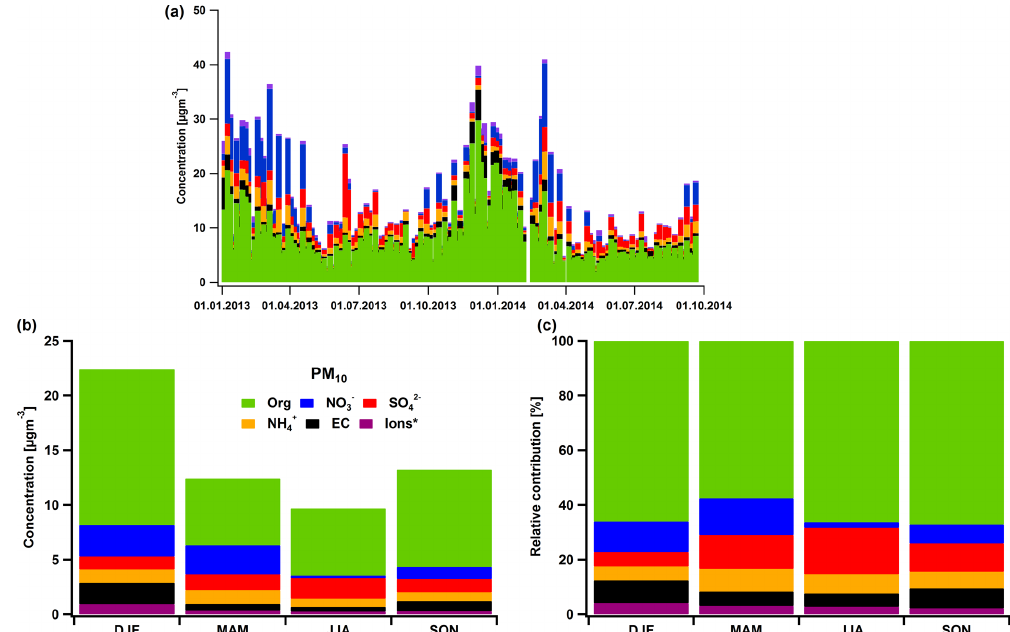
Figure 1. Concentrations of OM, EC and major ionic species for the years 2013 and 2014 (a) , their seasonal concentrations (b) and relative contributions to the total measured mass within the particulate matter (PM 10 ) (c) . The sum of the ions Na + , K + , Mg 2 + , Ca 2 + and Cl − are included in the indication “Ions ∗ ”.